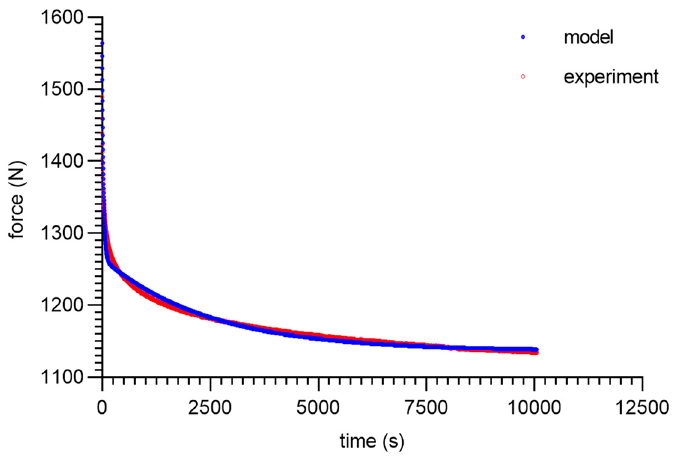
Figure 11. Material 80 ShA—five-parameter relaxation model and experimental data for ε = 100% .